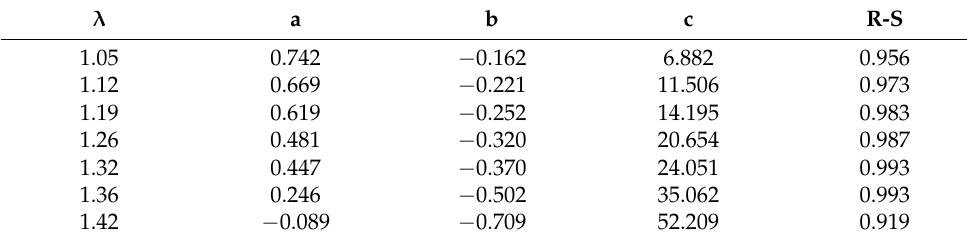
Table 7. Fitting parameters of CA50 and PMAX distribution under different λ .